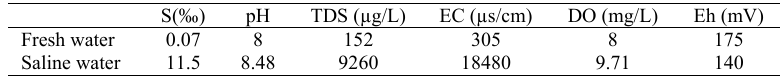
Table 3: Fresh and saline water important physicochemical parameters at the location of sampling